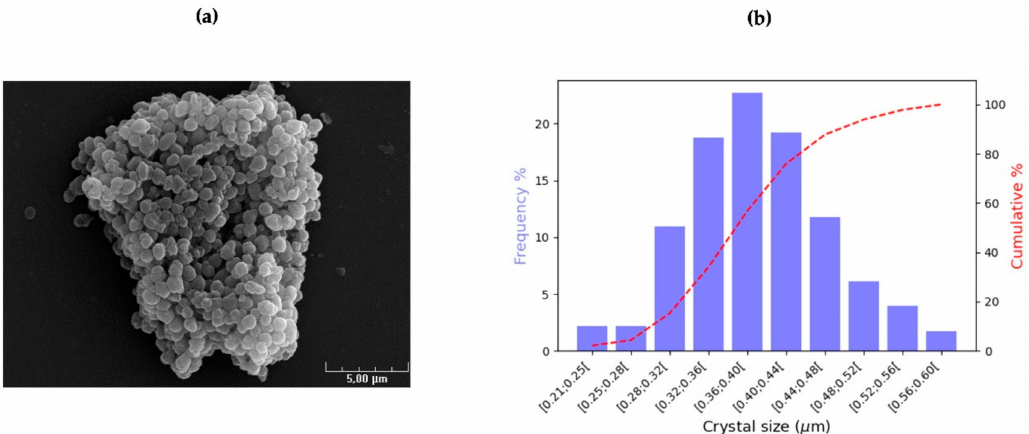
Figure 5. ( a ) SEM image of the AM65-52 purified crystals. ( b ) Graph representing the radius size distribution in terms of frequency and cumulative percentage for the spherical crystals.